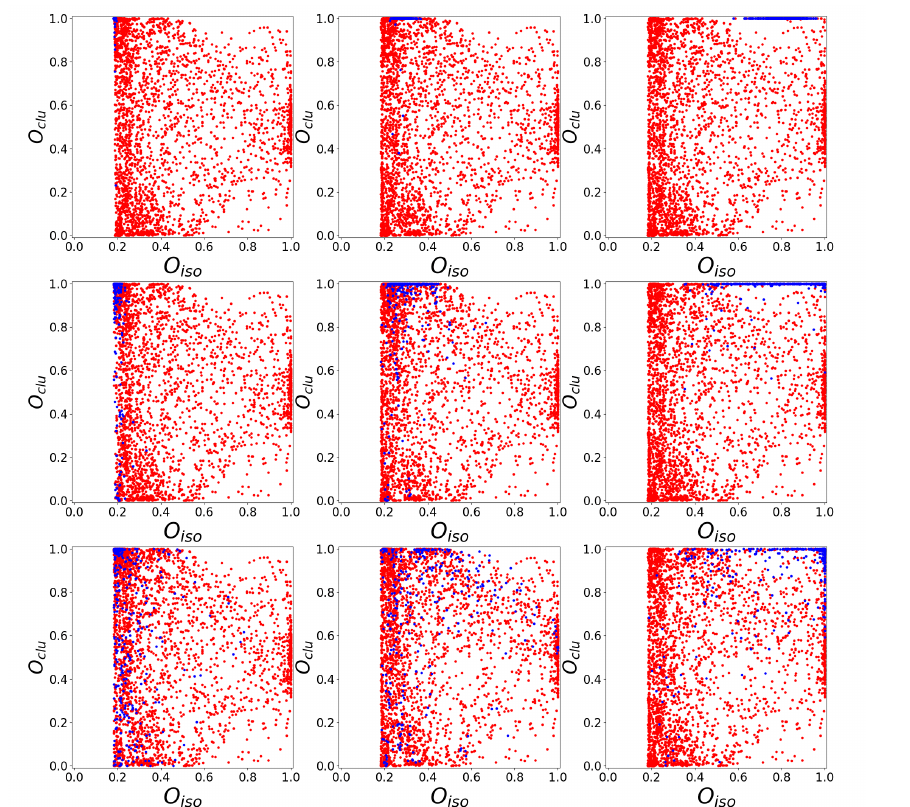
Figure 4 . Distribution of novelty scores in the O iso − O clu plane for the 2D Gaussian testing samples corresponding to the same BPs as in figure